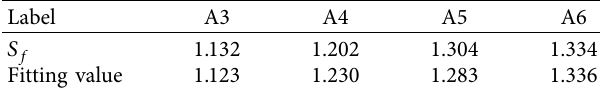
Table 3: Influence factor S f of static compressive